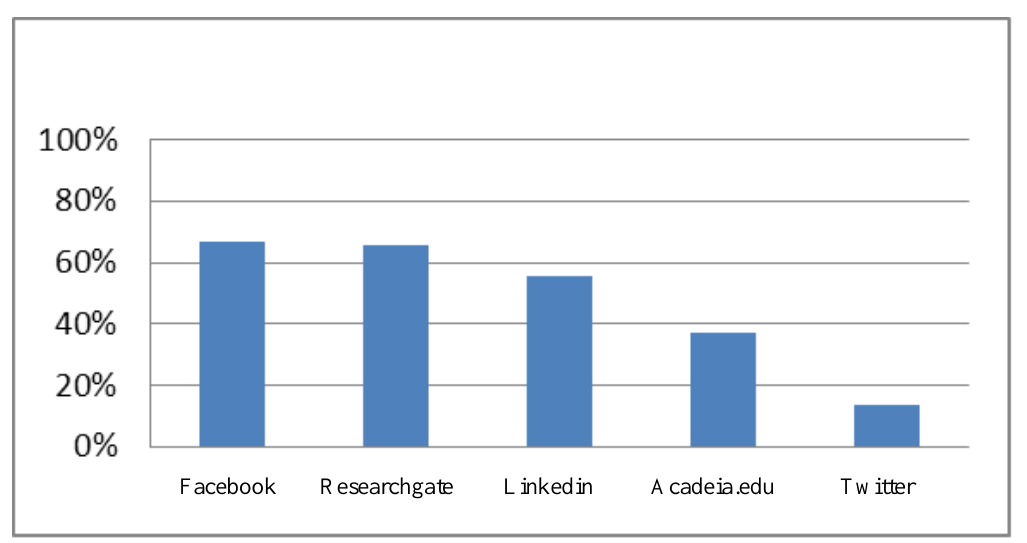
Figure 2. Rate of account ownership on social-networking